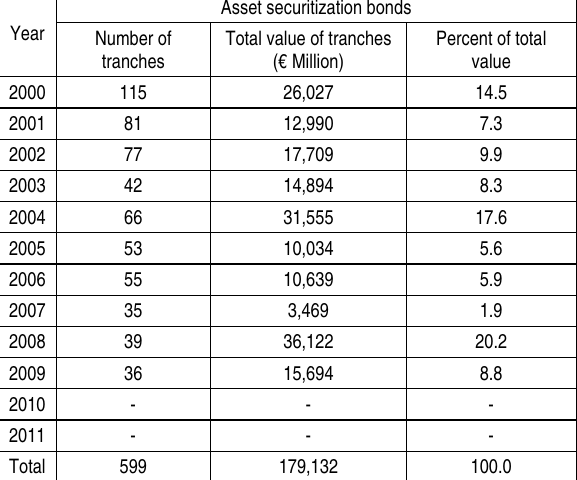
Table 1. Distribution of the sample of asset